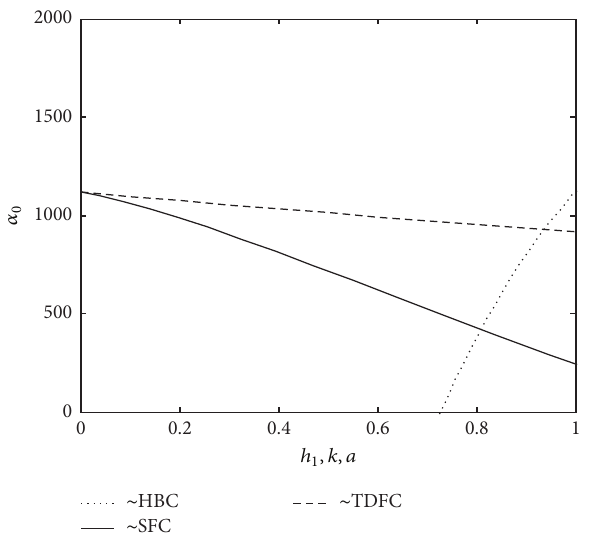
Figure 7: 𝛼 0 dependence on ℎ 1 , 𝑘 , 𝑎 with 𝛾 = 0.8